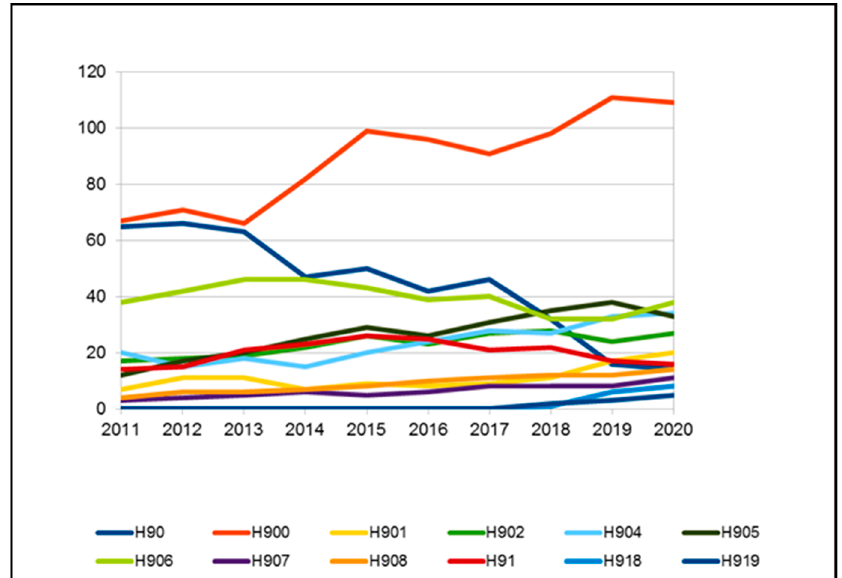
Figure 4. Subjects affected by hearing loss subdivided according IC10 classification into further